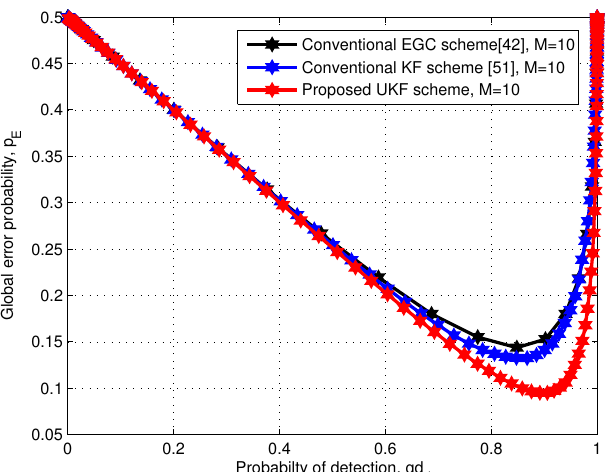
Figure 10. Probability of error comparison between an equal gain combining (EGC), Kalman filter (KL) and unscented Kalman filter (UKF) with different numbers of CUs, i.e., M = 10 and signal to noise ratio (SNR) = [ − 8, − 11, − 14, − 17, − 20, − 8, − 11, − 14, − 17, −